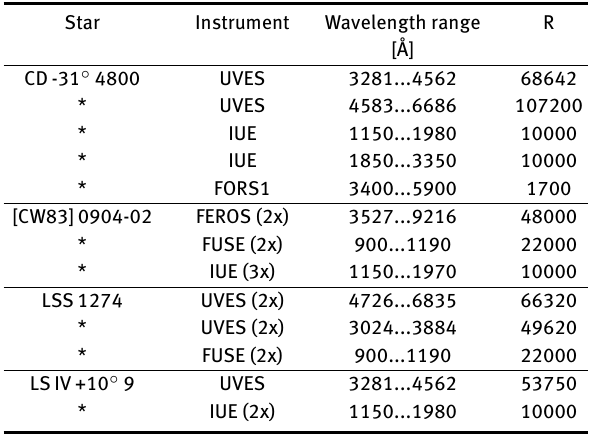
Table 1. Information about the sample stars analyzed in this